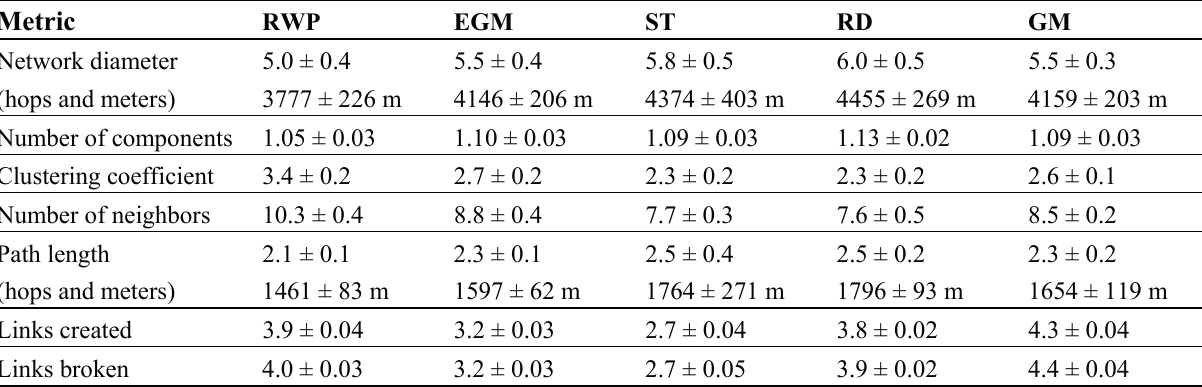
Table 2. Mobility models